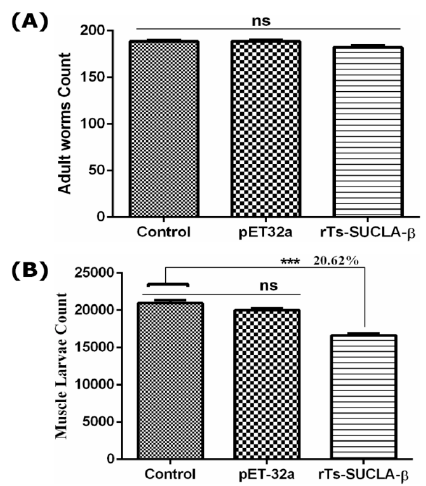
Figure 9. Parasite reduction in treated rats following challenge with 200 T. spiralis larvae per rat. ( A ) Adult larva count. No significant reduction of adults was observed between the groups. ( B ) Muscle larva burden reduction. The rTs-SUCLA- β showed 20.62% reduction of ML larva as compared to control. The purified pET-32a protein group and control group were non-significant. The results are presented as mean standard error of 10 mice per group. Significant di ff erences was marked with *** when p < 0.001.